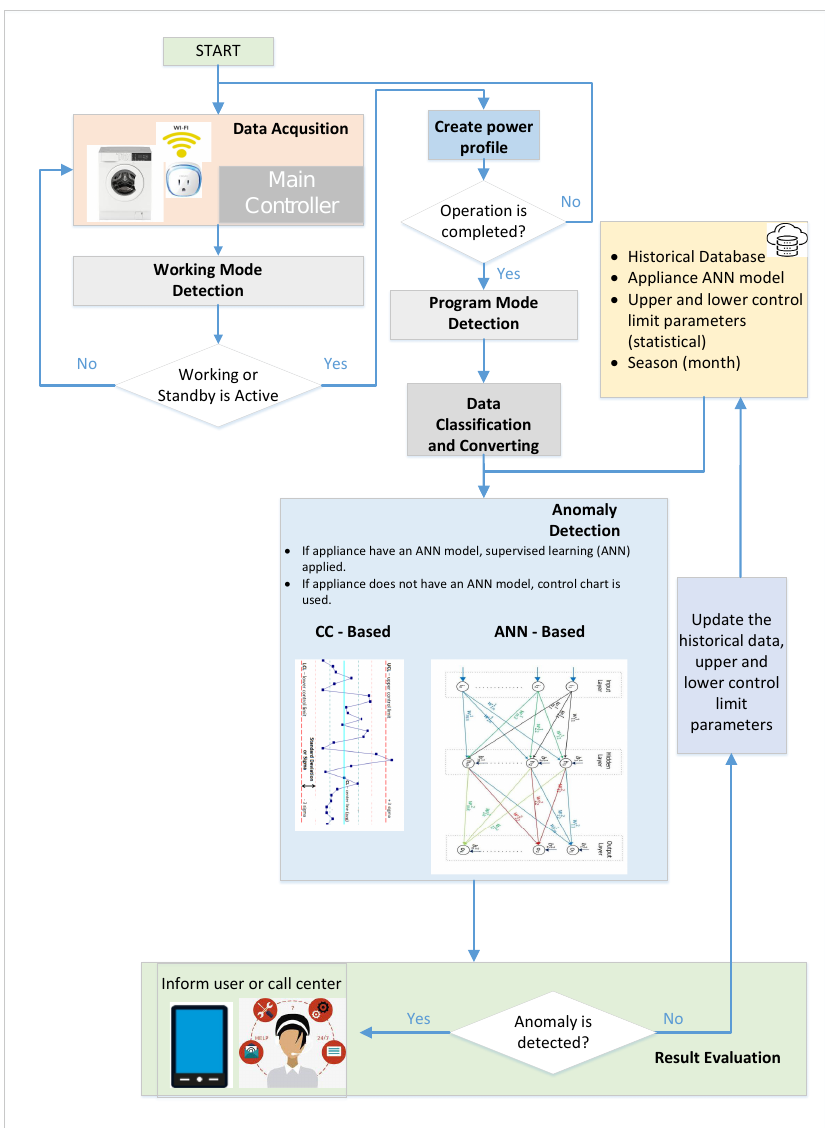
Figure 7. The flowchart of AM-ADS procedure.